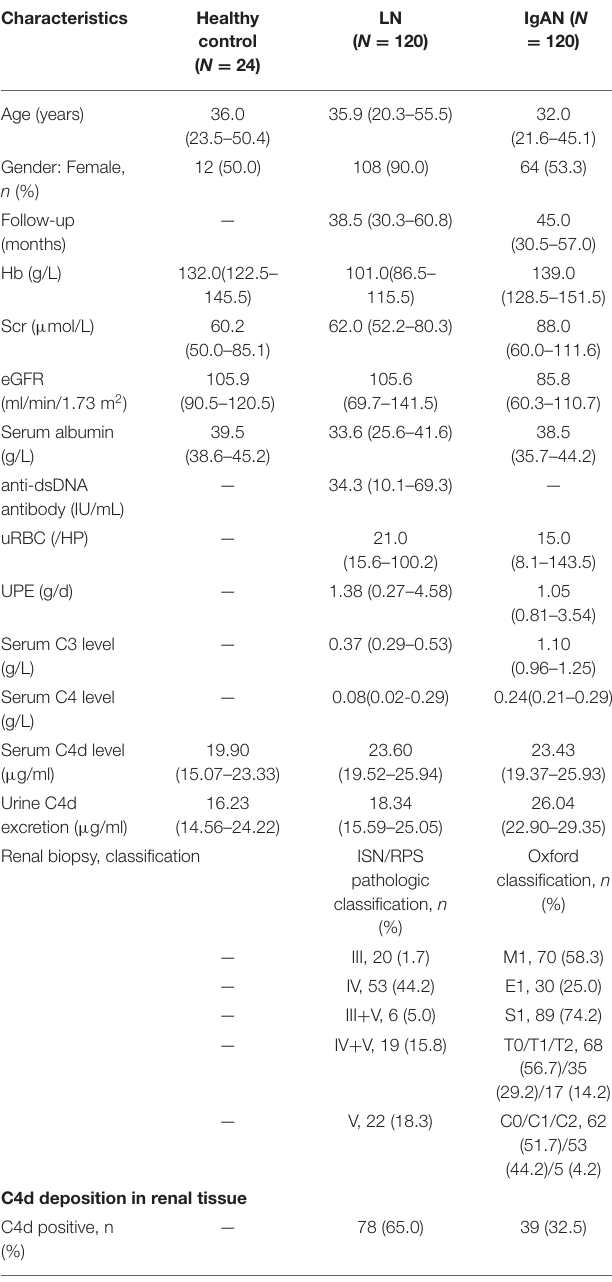
TABLE 2 | The C4d distribution patterns in renal tissue for LN and IgAN patients. C4d distribution in renal